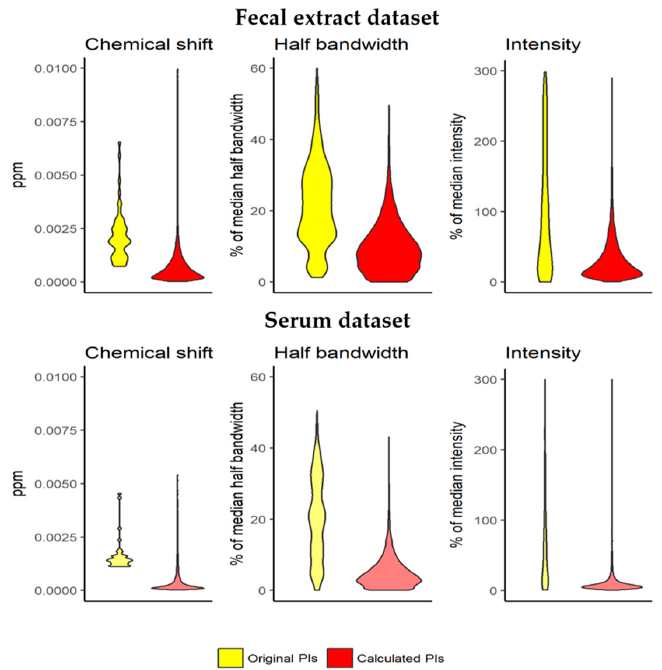
Figure 3. The spectrum-specific 95% PIs of the parameter values PIs are much narrower than the spectrum-unspecific 95% PIs. Chemical shift PIs are generally lower than the bucketing applied (6 × 10 − 4 ppm). The narrow PIs enhance the performance of error minimization algorithms to end in the right local minimum.